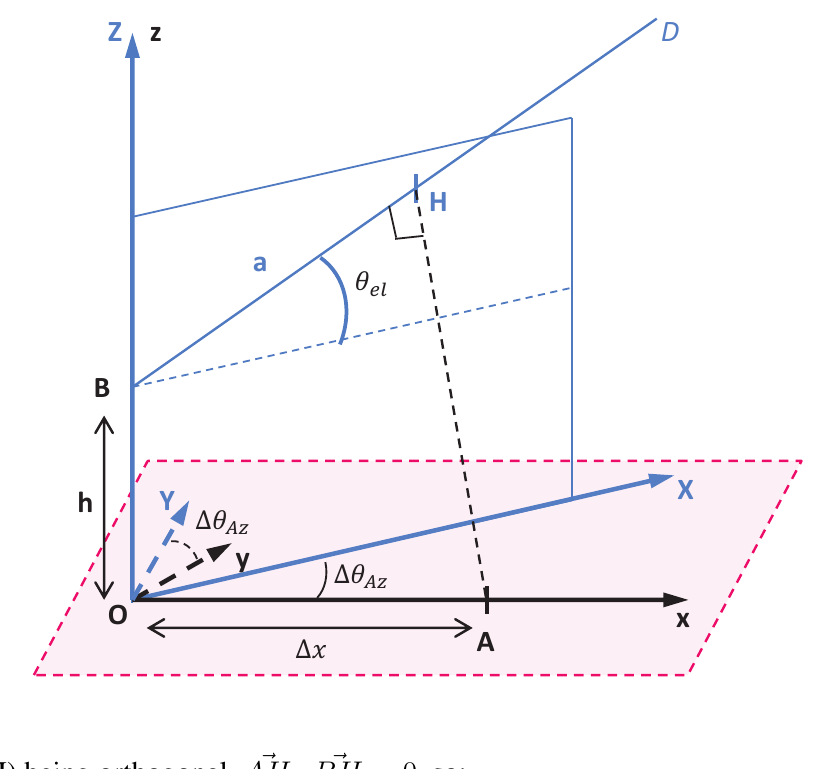
Figure A1. Geometry of the experimental